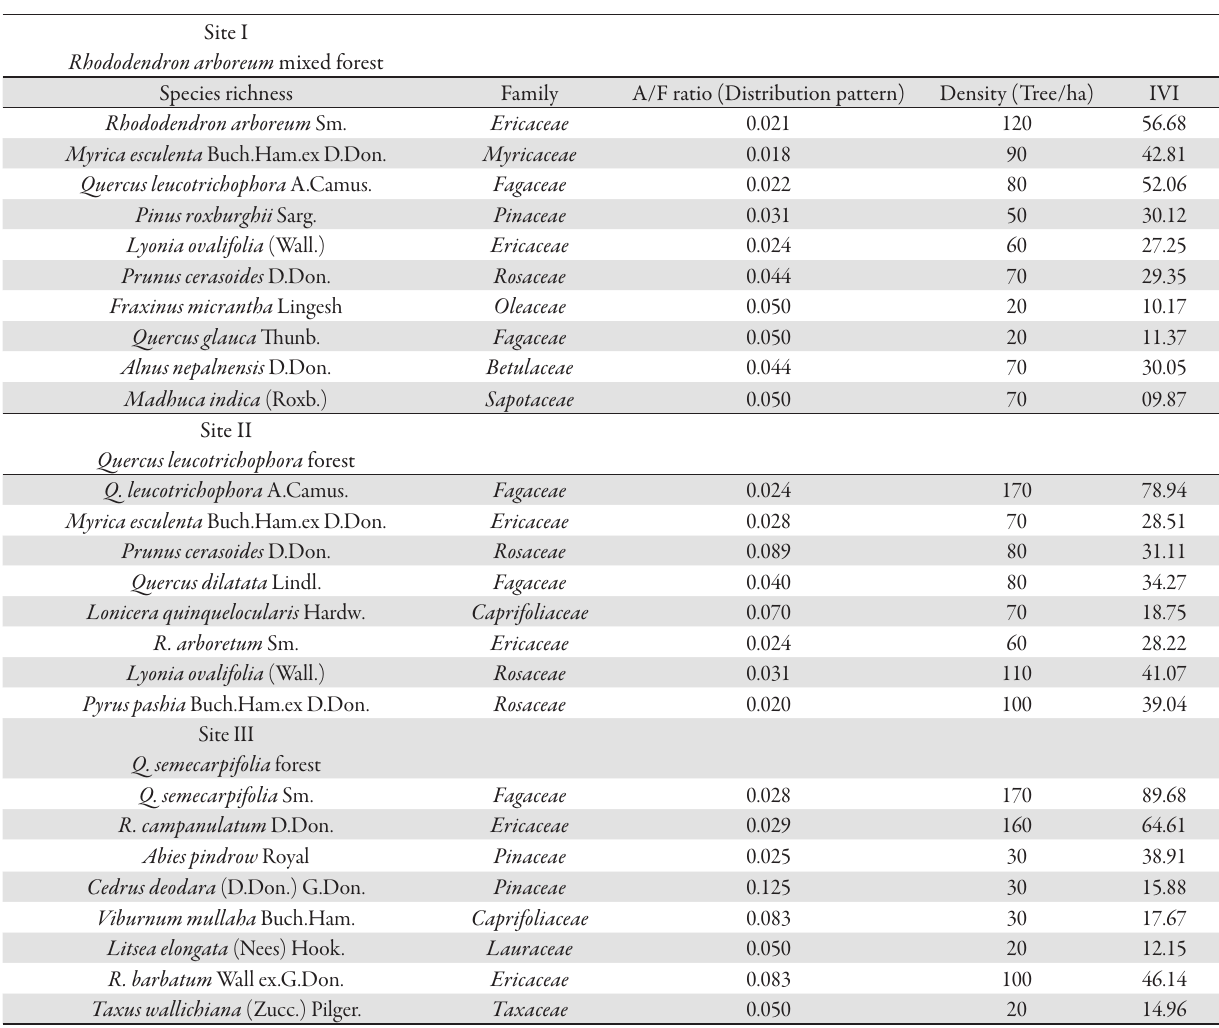
Tab. 1. Structure and composition frequency (%), density (tree/ha) and importance value index (IVI) of three forests types